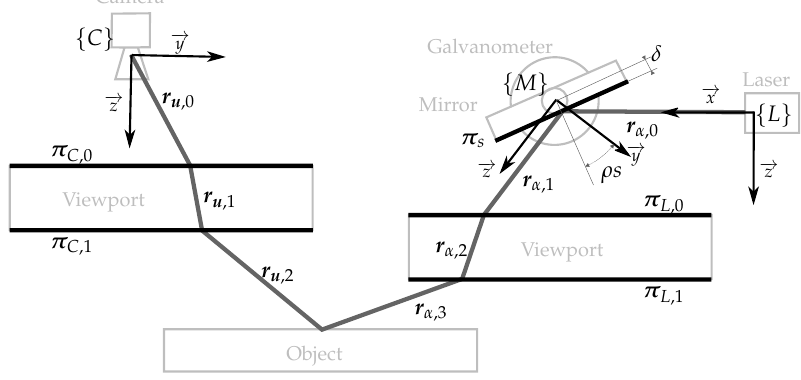
Figure 3. Illustration with the different elements of the sensor (light grey), the elements of the mathematical model (black) and the light path (dark grey).